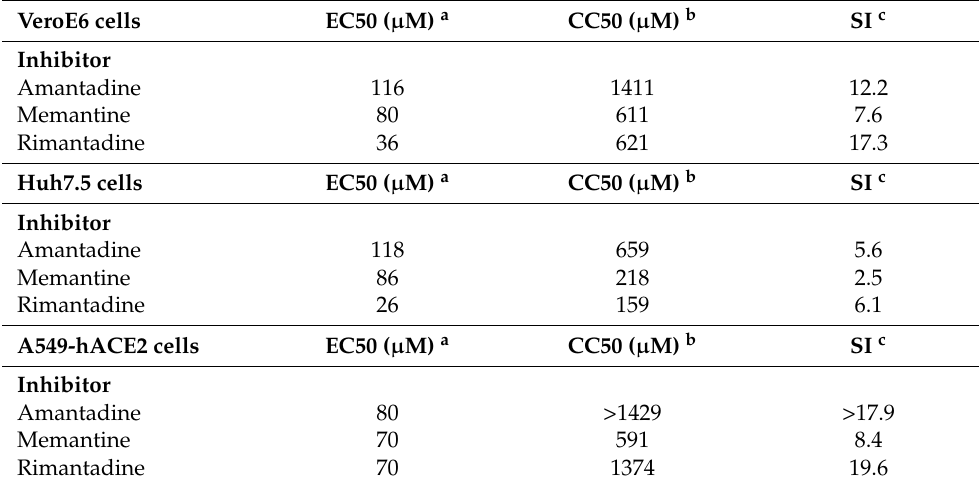
Table 1. Potency, cytotoxicity and selectivity indexes of ion-channel inhibitors in